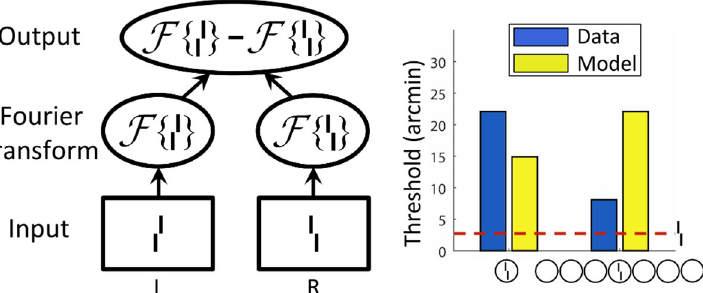
Fig 13. Fourier model. Left. The Fourier model computes Fourier transforms for the left- and right-offset versions of each stimulus. If these transforms are very different, crowding is low because the offset direction is easy to decode in Fourier space [15]. Right. Output of the Fourier model. The model failed on most stimuli [15]. NB. This model only produces a scalar output, there is no output image.